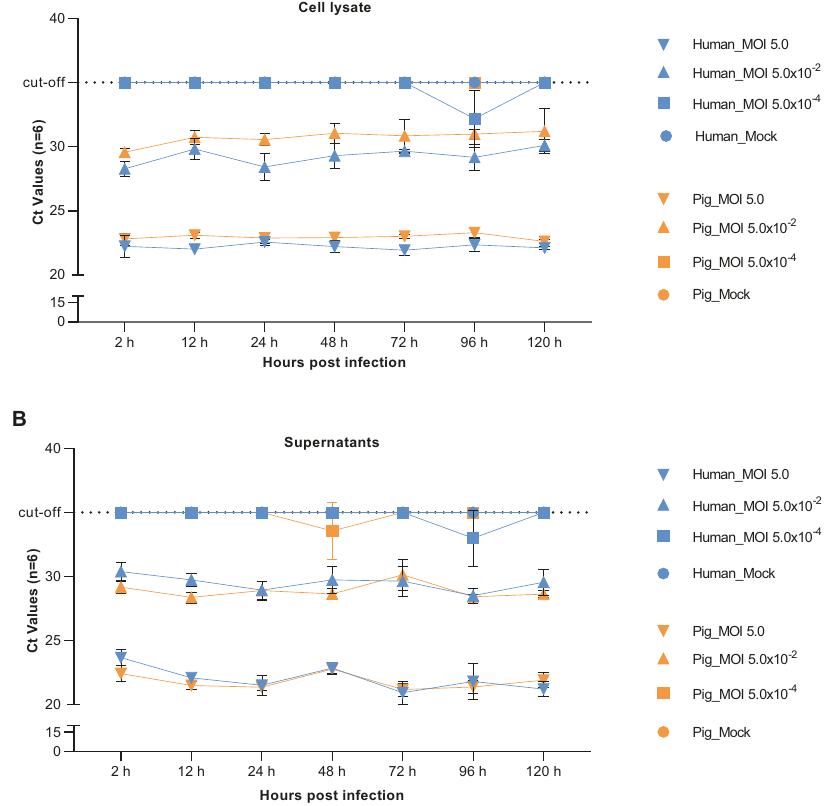
Fig. 5 Analysis of SARS-CoV-2 replication in cell lysates and supernatants HRECs and PRECs. Detection of SARS-CoV-2 viral nucleocapsid (N) gene using EZ ™ -SARS-CoV-2 Real-Time RT-PCR developed by Tetracore. A volume of 7 μ L Trizol extracted viral RNA sample was used in each reaction, and all RT-qPCR reactions were set up by including negative, positive, and no-template controls (NTC). Data from 6 technical replicates at each dose. Blue — HRECs (human), Orange — PRECs (pigs) ( n = 6). A Line graphs showing viral growth over time in cell lysates and B the supernatants of HRECs and PRECs inoculated with SARS-CoV-2 at MOI 5.0, 5.0 × 10 − 2 , 5.0 × 10 − 4 , or mock-inoculated with culture